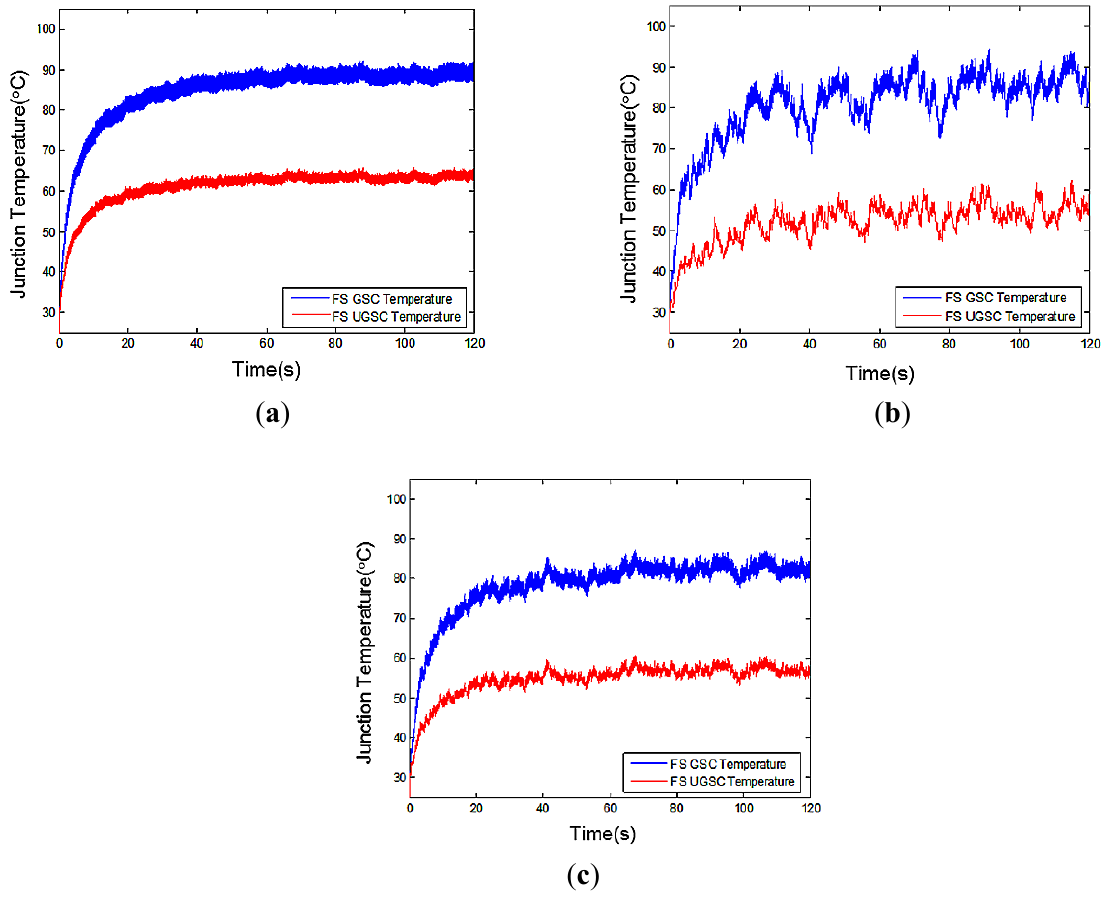
Figure 12. Temperature profile of FS based PECs with ( a ) conventional fixed DC link voltage; dynamic DC link ( b ) without and ( c ) switching frequency adaption schemes in generator side (GS) and utility grid side